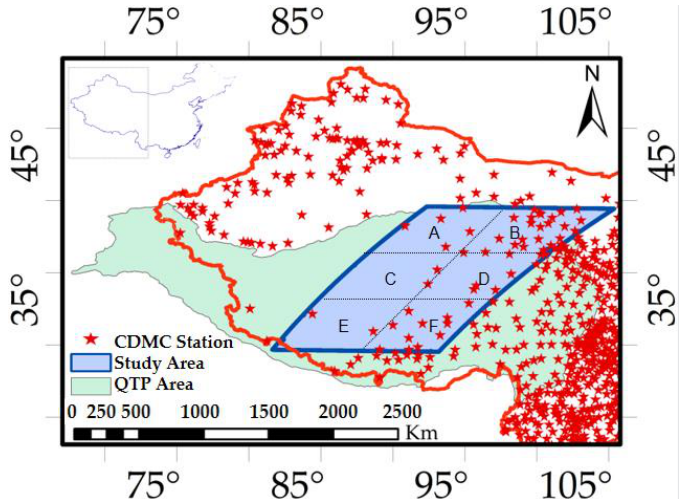
Figure 1. Location of study area (blue polygon) and six subareas (A to F) in the Qinghai–Tibetan Plateau, China. Red asterisks indicate the locations of CMDC stations.